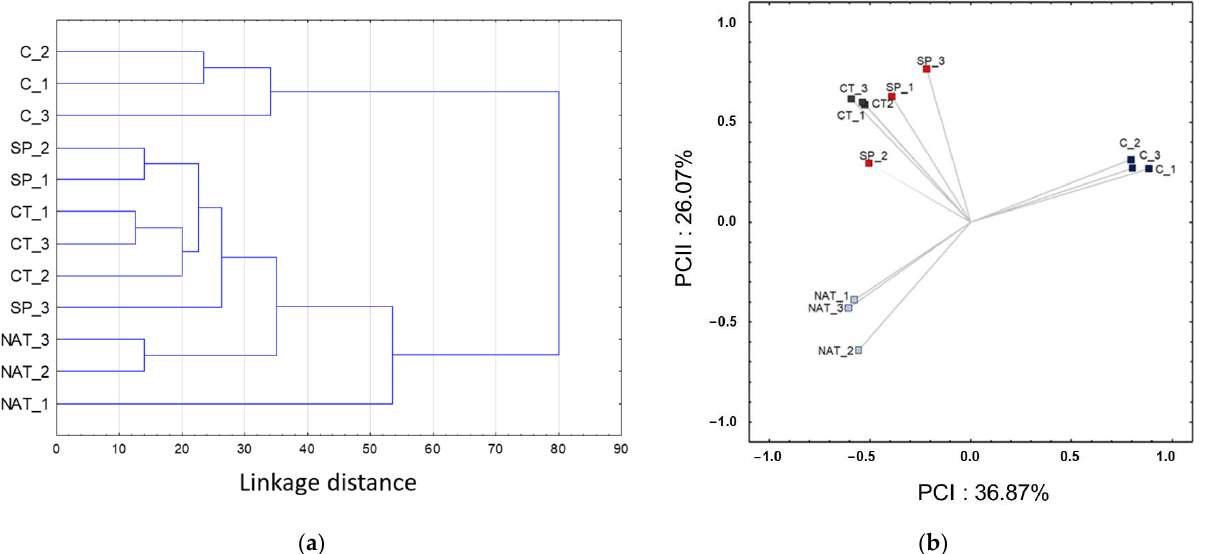
Figure 5. Numerical clustering ( a ) and principal component analysis (PCA) ( b ) of the three replicates of integrated NMR spectral data of control (C) and treated plants (CT, SP and NAT). The classifica- tion dendrogram clearly aggregates the control group separately from all fertilization treatments. The ordination plot also shows a clear separation along the first principal component of the C versus treated plants, whereas the second component segregates the NAT from the other organic fertiliza- tion treatments.